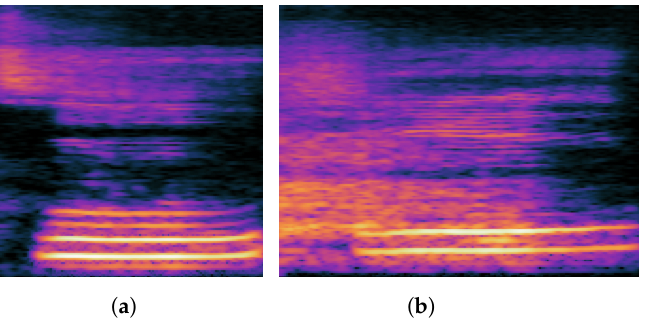
Figure 4. Spectrum comparison of affrication and correct: ( a ) affrication; ( b )